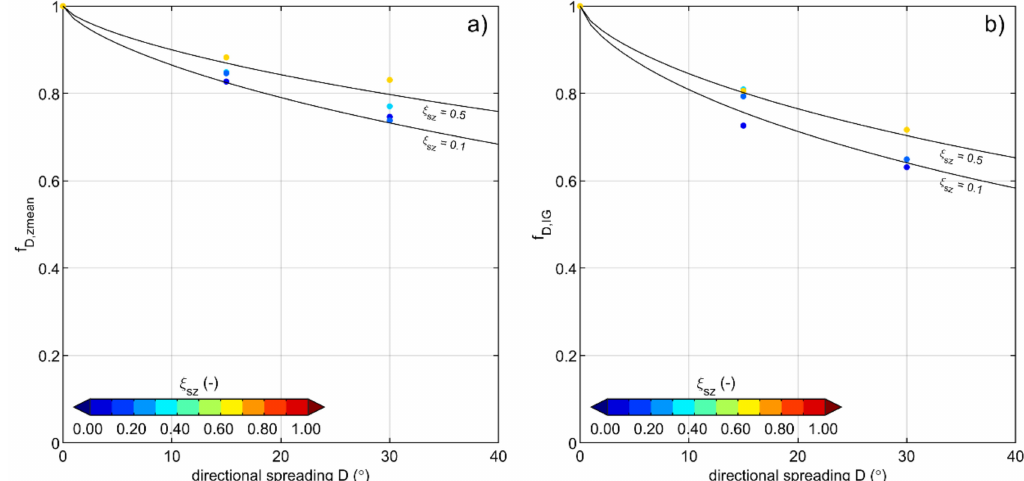
Figure 14. Computed directional spreading reduction factors f D for set-up ( a ) and infragravity run-up ( b ). Solid lines show the empirical fit with ξ sz of 0.1 and